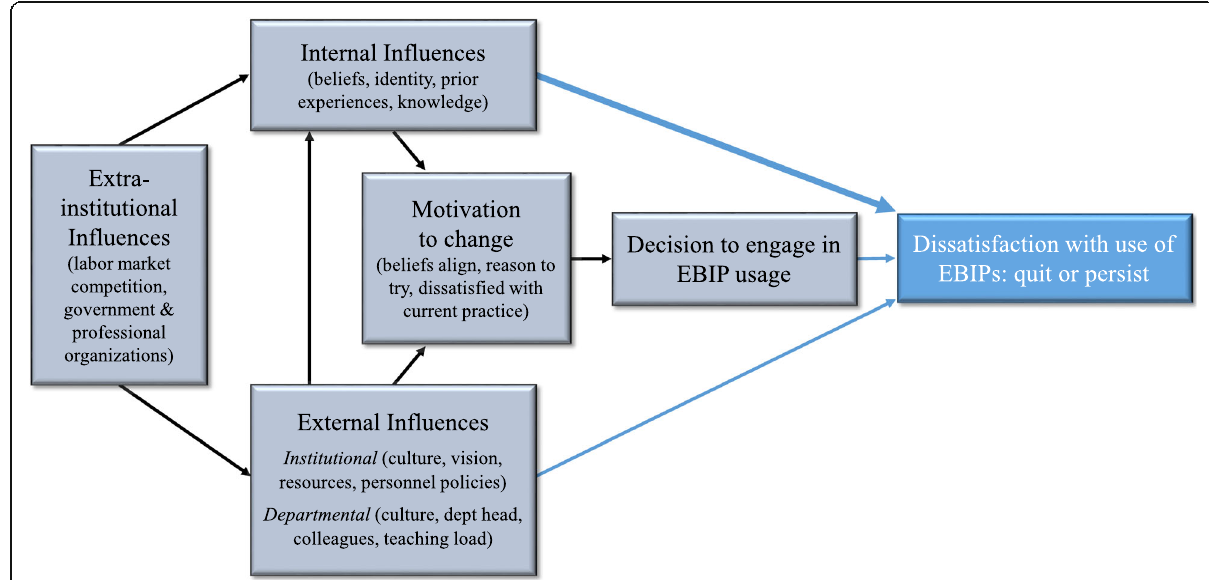
Fig. 5 Suggested revised model for faculty ’ s decision-making process on using EBIPs. Additions to the framework based on results of the FIBIS pilot data are in blue/white. Arrow bolded indicates greater influence in the relationship. Note that arrows indicate theoretically-based, as opposed to empirically tested, relationships. This model will need to be confirmed in future